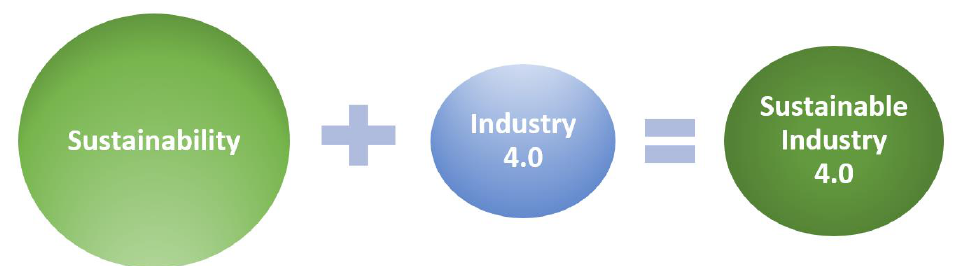
Figure 10. The synthesis of bibliometric analysis: Sustainable Industry 4.0. Source: Own study based on bibliometric analysis.